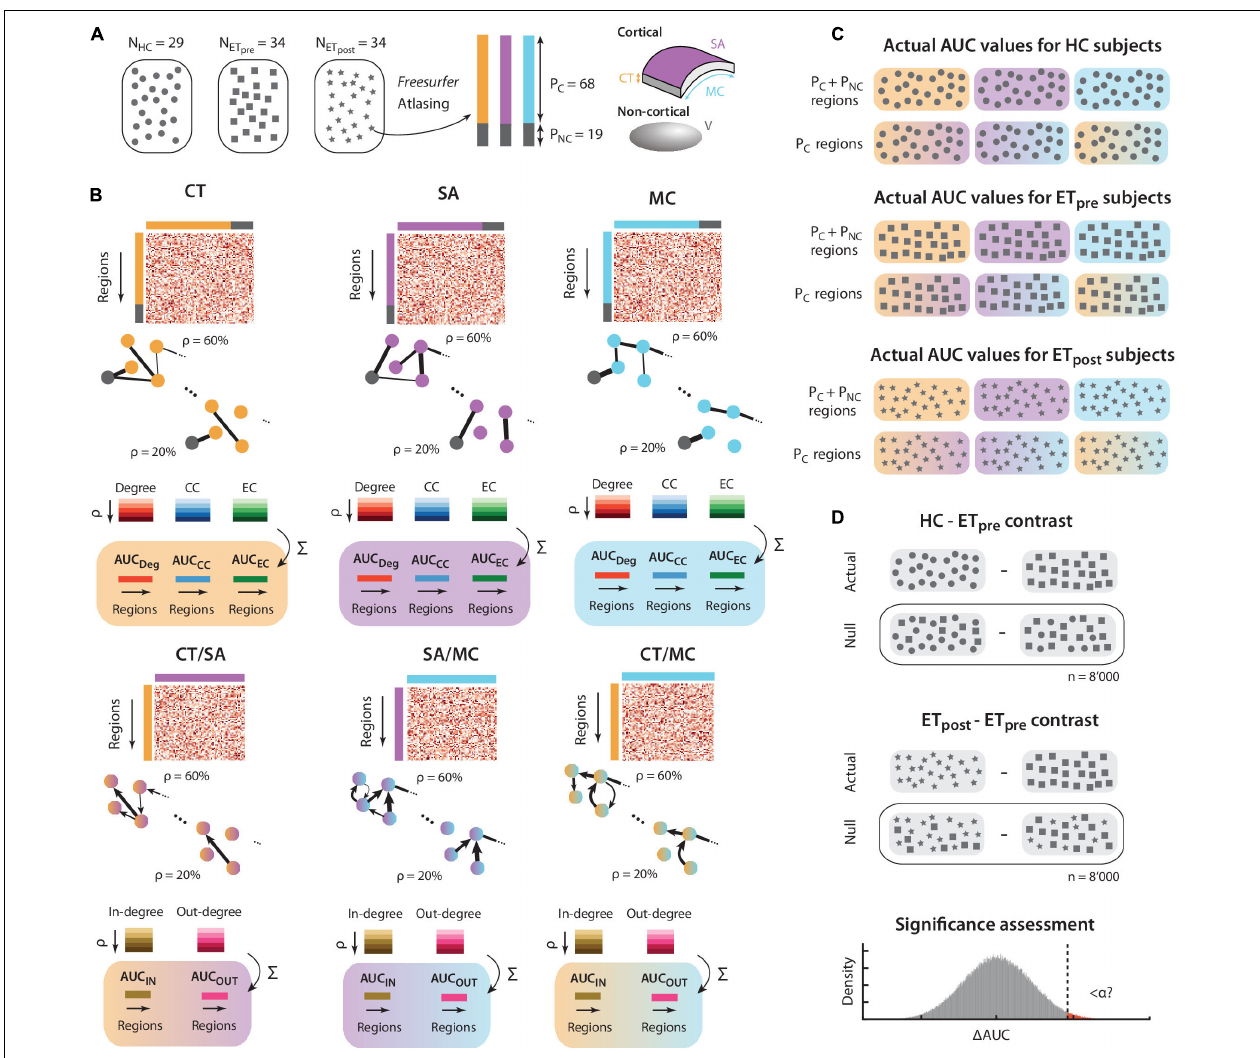
FIGURE 1 | Schematic description of the method. (A) We consider three groups of subjects: healthy controls ( N = 29, depicted by circles), and drug-resistant ET patients before and 1 year after Vim thalamotomy ( N = 34, respectively denoted by rectangles and stars). For each structural scan, following Freesurfer -based processing and atlasing into regions of interest, the P C = 68 cortical areas at hand can be described by their thickness (CT, orange), surface area (SA, purple), and mean curvature (MC, cyan). The P NC = 19 non-cortical areas are characterized by their volume (V, gray). (B) Similarly for each of the three groups of subjects, cross-regional structural covariance is computed across subjects for CT (top left panel), SA (top middle panel), and MC (top right panel). The extracted information can equivalently be summarized in a matrix, or in a graph, where negative-valued structural covariance is set to zero. Regional degree, clustering coefficient (CC), and eigenvector centrality (EC) are computed for graph densities ranging from 20 to 60%, and the area under the curve (AUC) is taken as a regional output measure of interest for each morphometric property and graph metric case. In a similar fashion, cross-property covariance can be computed for the CT/SA (bottom left panel), SA/MC (bottom middle panel), and CT/MC (bottom right panel) cases. The obtained graphs are then directional, and in-degree and out-degree can be computed across graph densities to generate AUC output measures. (C) The computations described in panel (B) are performed similarly for the HC, ET pre , and ET post groups. Note that cross-property metrics are only available for the P C cortical regions. There is a total of 15 separate subcases with output AUC values: 3 morphometric properties (CT, SA, and MC) for 3 graph theoretical metrics (degree, CC, and EC), plus 3 cross-property pairs for 2 graph theoretical metrics (in-degree and out-degree). (D) Similarly for each of the 15 subcases at hand, the regional difference in AUC can be computed between the HC and ET pre groups, or between the ET post and ET pre ones. The process described in panel (B) is then rerun n = 8’000 times after randomly shuffling the subjects across groups, to generate a null distribution of AUC differences. The actual value (vertical dashed line) is eventually compared to this null distribution to assess significance, with proper correction for the number of examined regions and subcases in